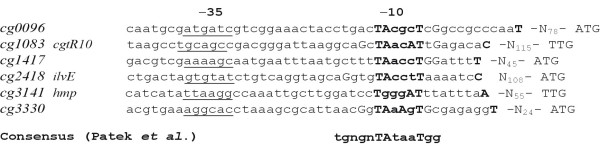
Promoter sequences of C. glutamicum genes showing elevated expression at the onset of stationary phase. The transcription start sites mapped by RACE PCR assays are shown in boldfaced, capital letters. The numbers indicates the position of the transcription start site relative to the translational start codon. The deduced -10 sequences are shown in bold, the -35 elements are underlined. Nucleotides that match the proposed consensus for the -10 element of C. glutamicum are symbolized by capital letters. The consensus sequence of the -10 element of the C. glutamicum sigma factor SigA [tgngnTAtaaTgg] is shown for comparison [19].